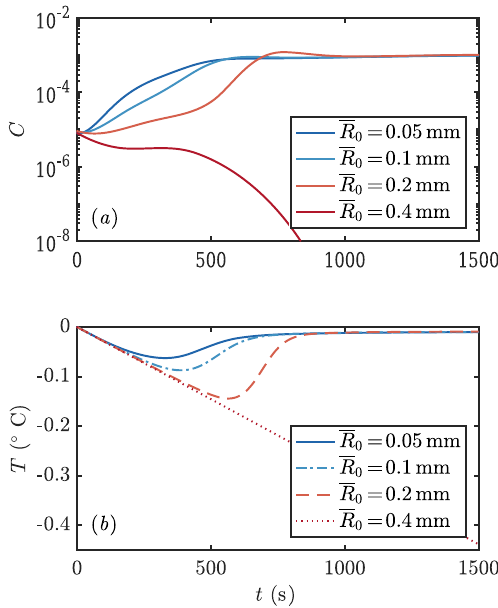
Figure 8. Numerically calculated steady-state crystal size distribu- tions using the three growth rate formulae discussed in Sect. 1.2. The parameters are as in Fig.